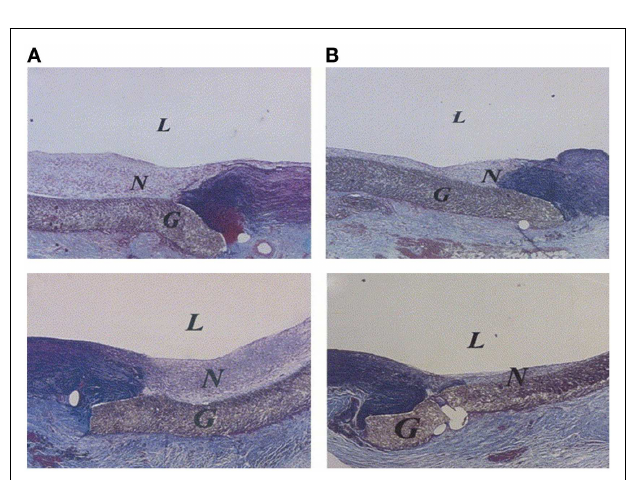
FIGURE 1 | Neointimal hyperplasia at proximal (top) and distal (bottom) anastomoses . Collagens are blue; elastin is black; others are red. (A) Anastomoses of untreated expandable poly(tetrafluoroethylene) (ePTFE) graft (control). (B) Anastomoses of heparin-coated ePTFE graft (treated). L, Lumen; N, neointima; G, ePTFE graft material (Verhoeff-Masson stain; original magnification: 40 × ) (Lin et al., 2004).